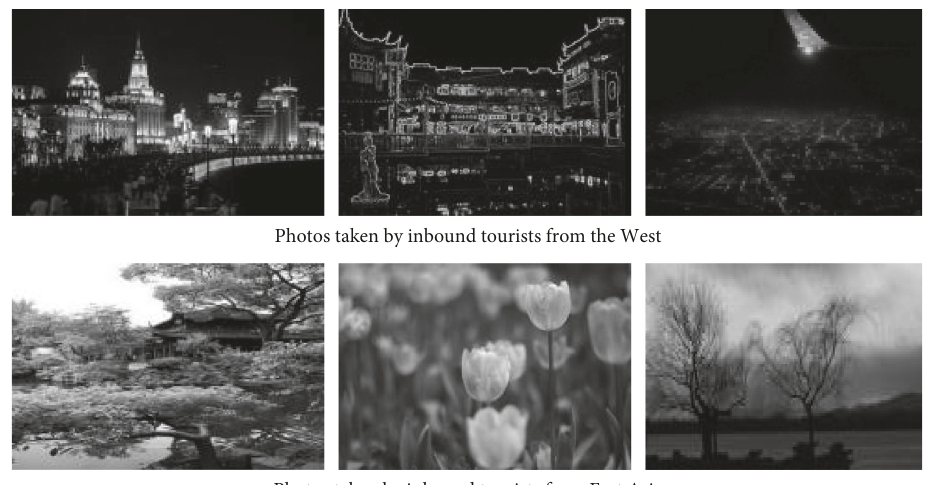
Figure 4: Comparison of photos taken by Western and East Asian inbound tourists. (a) Photos taken by inbound tourists from the West. (b) Photos taken by inbound tourists from East Asia.